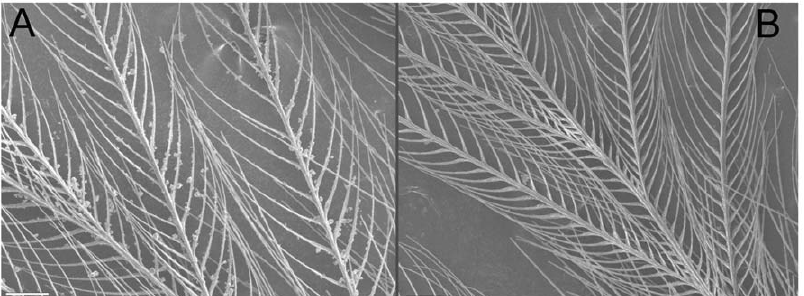
Figure 4. Removal of feather soling by the ethanol treatment. Example of a white feather from a black-capped chickadee affected by avian keratin disorder before ( a ) and after ( b ) washing with 50% ethanol. Scale bar is 100 m m.